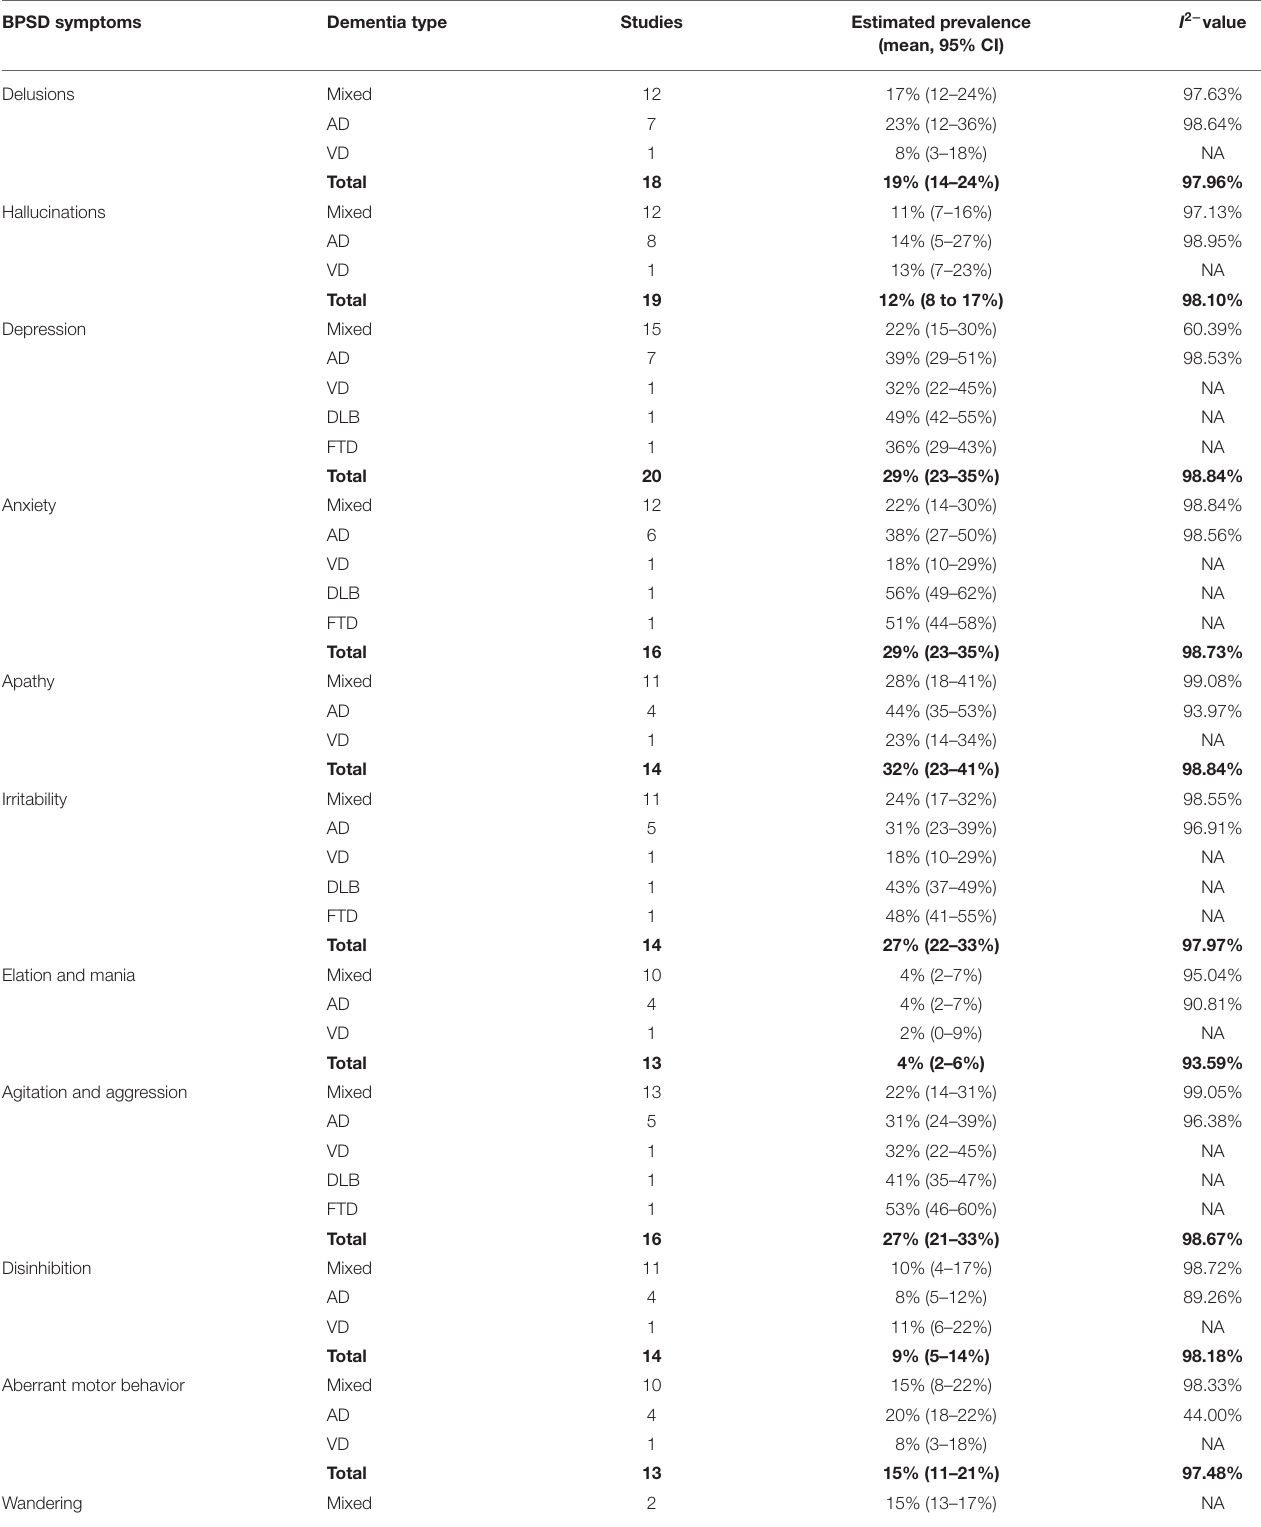
TABLE 3 | Prevalence of BPSD in community-dwelling dementia